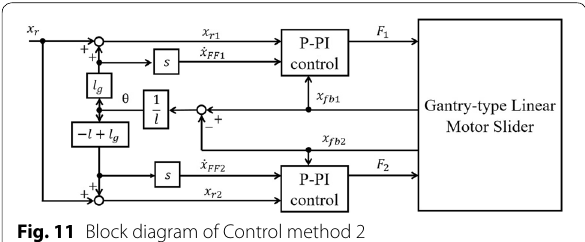
Fig. 11 Block diagram of Control method 2